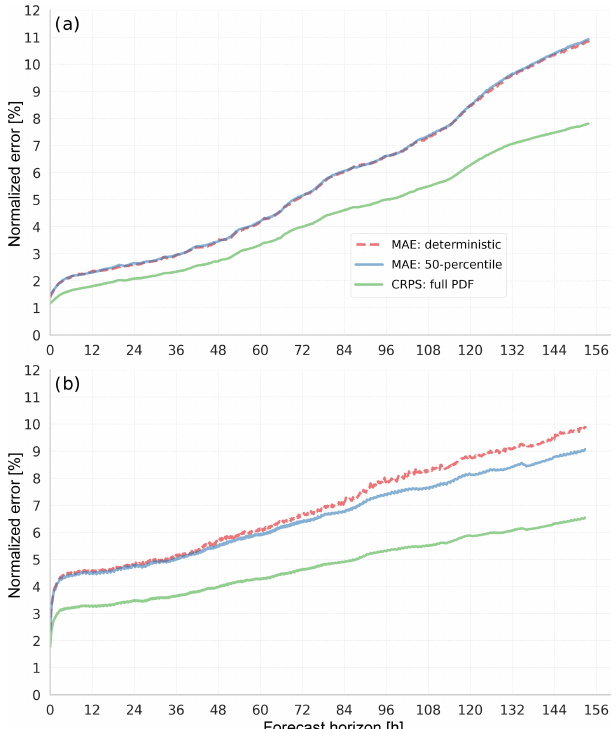
Figure 3. Comparing CRPS scores of the full distribution with the equivalent MAE of deterministic forecasts and the distribution median (50-percentile) shows the additional information from the probabilistic output. (a) Germany, EEX energy trading data. (b) Sin- gle wind farm.